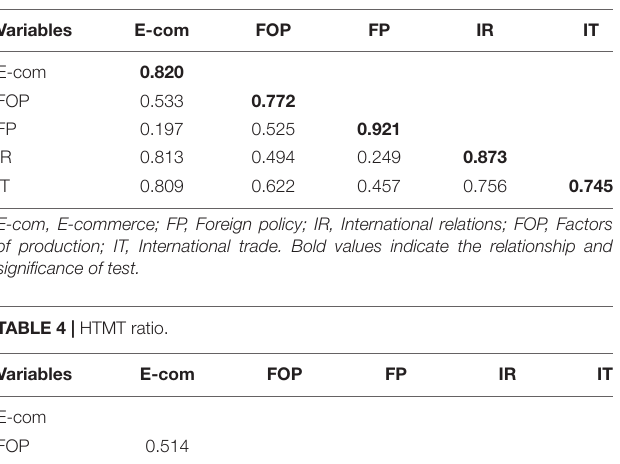
TABLE 3 | Fornell and Larcker criterion.